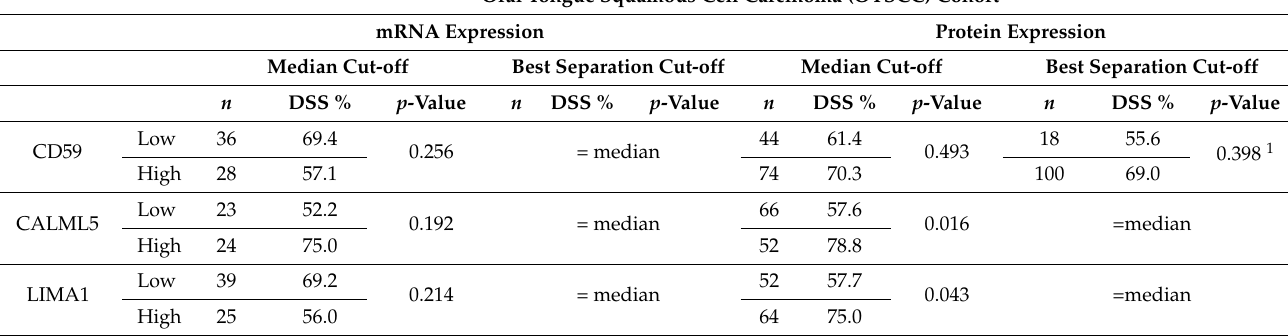
Table 5. Target protein and mRNA expression in the oral tongue squamous cell carcinoma cohort using median and best separation cut-off, and their association with 5-year disease-specific survival (DSS) in Kaplan–Meier analysis. The p -value was calculated using the log-rank test, with the significance level set to